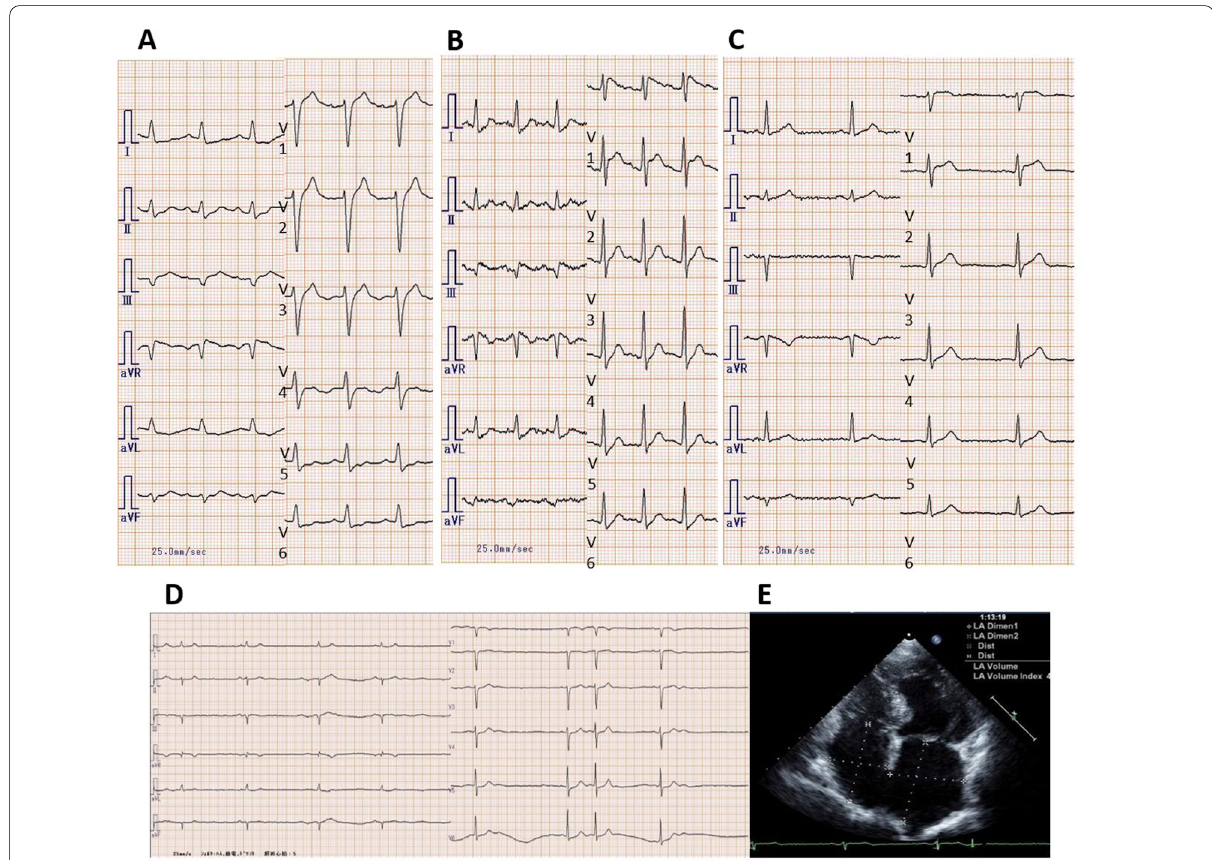
Fig. 1 Electrocardiographic changes after ventricular fibrillation. a ECG two days after ventricular fibrillation. b ECG 30 days after ventricular fibrillation showing typical coved-type ST elevation in lead V1. c ECG five months after ventricular fibrillation. d ECG and echocardiography of the patient’s mother just before pacemaker implantation, showing no Brugada-type ST elevation. e Echocardiography showed mild left